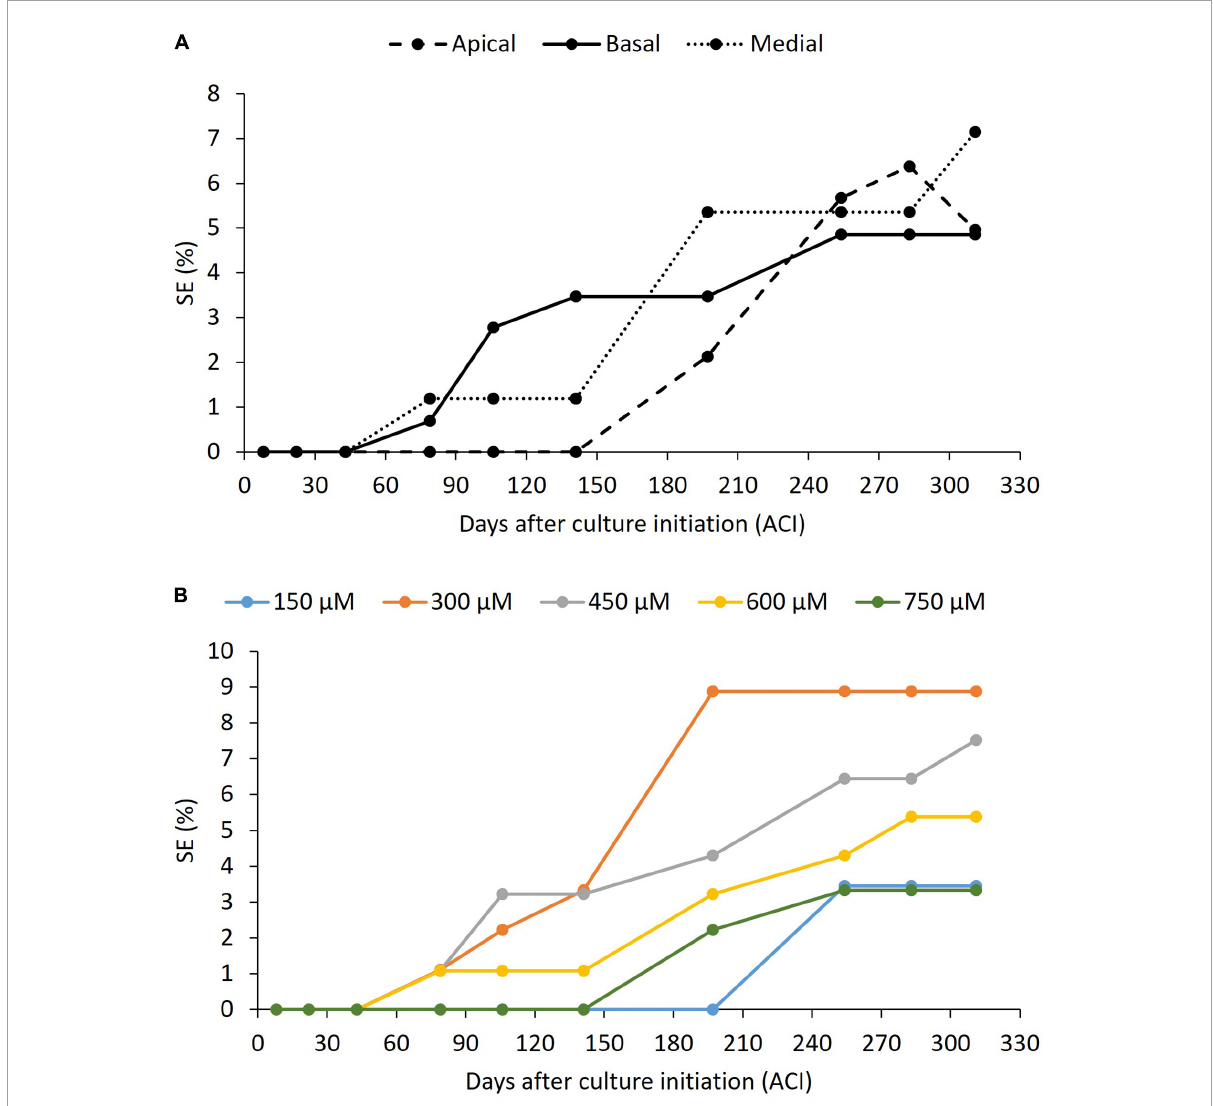
FIGURE6 Effect of the peach palm TCLs position (A) and picloram concentration (B) on induction of somatic embryogenesis (SE). p -value was above 0.05 in all cases according to chi-square test at 95% confidence level. Exact p -values can be found in Supplementary material . At least nine replicates per treatment were